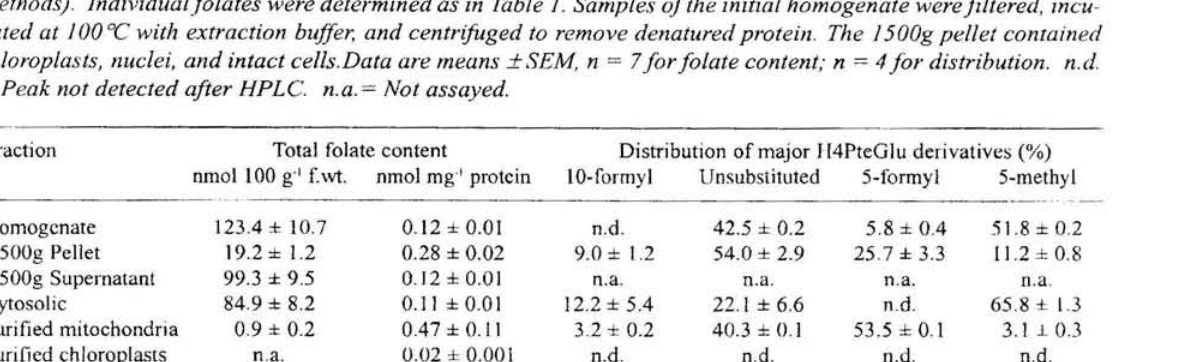
Table 2 The intraceUular distribution offolate derivatives in leaves of 14 dpea seedlings. Leaves were extract- ed under isotonic cnnditions and fractionated by dijferential centrifugation. Mitochondria and chloroplasts were purified on Percoll gradients. Each fraclion was assayed for total folate using L. rhamnosus (see Materials and Methods). Individualfolates were determined as in Table 1. Samples ofthe initial homogenate were filtered, incu- bated at IOO°C with extraction buffer, and centrifuged to remove denaturedprotein. The 1500gpellet chloroplasts, nuclei, and intact cells.Data are means ±SEM, n = 7 for folate content; n = 4 for distribution. n.d.